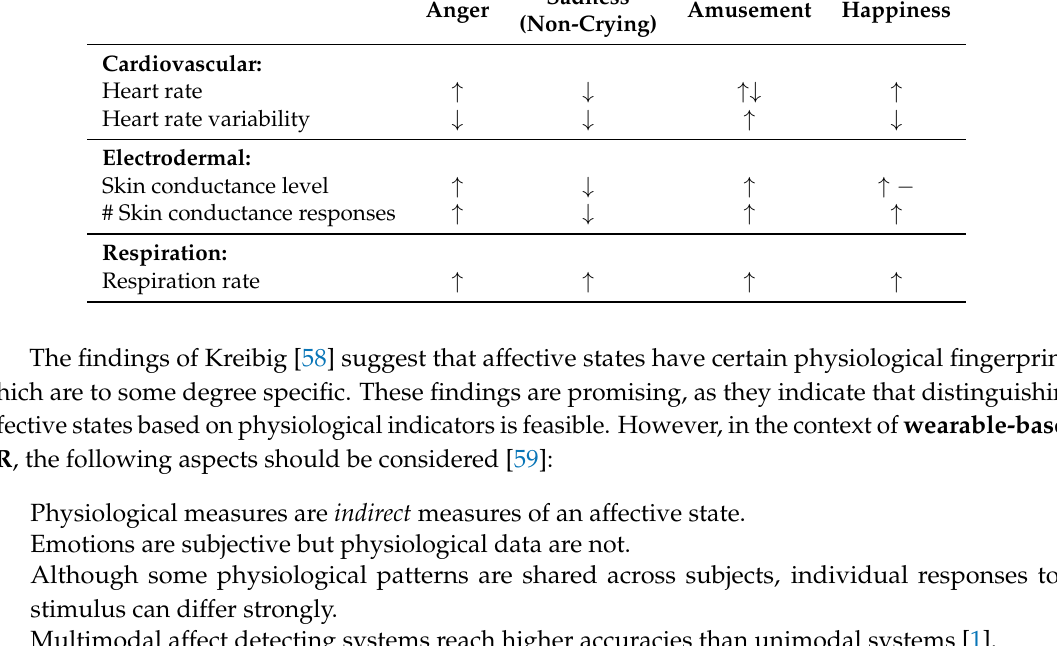
Table 2. Four exemplary affective states and their physiological response [58]. Abbreviations: ↓ indicate a decrease, ↑ indicates an increase, ↑↓ indicate both increase and decrease (depending on the study), − indicates no change in the parameter under consideration, # represents number of. Anger